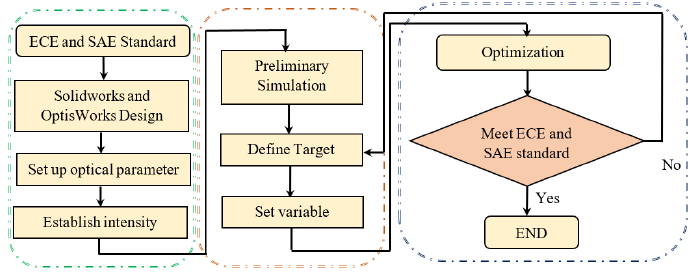
Figure 14. The optimization process flow chart.